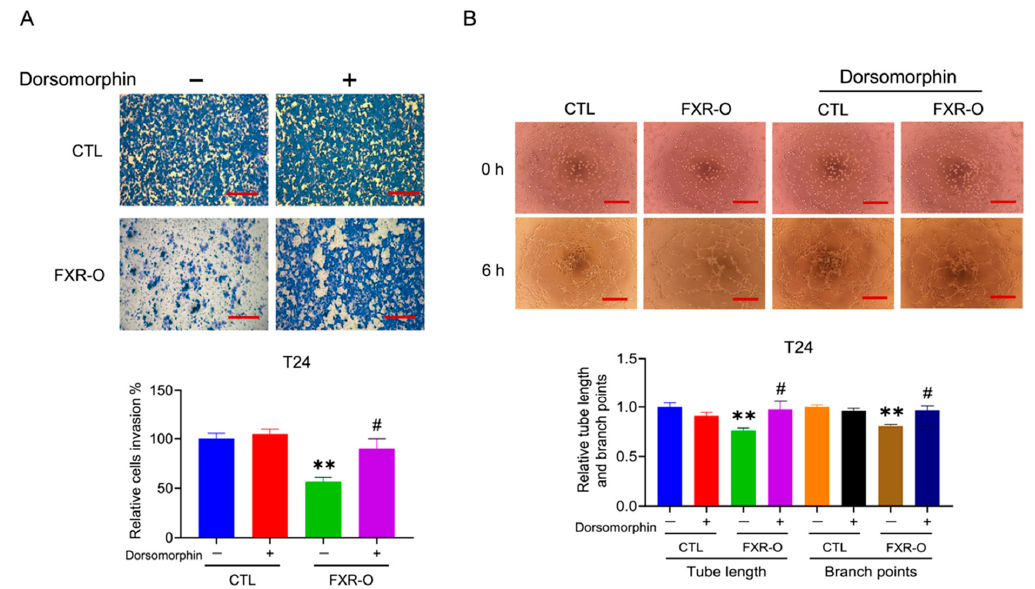
Figure 2. The effect of the AMPK inhibitor dorsomorphin on migration and adhesion in human bladder cancer cells after FXR overexpression. ( A ) The migratory ability of FXR-overexpressing (FXR-O) TSGH8301 and T24 cells treated with or without dorsomorphin (5 µM) was analyzed by wound healing assay after scratching for 6 h. The right panel shows the relative migration rate. ( B ) The adhesive ability in FXR-O TSGH8301 and T24 cells treated with or without dorsomorphin was analyzed after 50 min of incubation. Then, the adherent cells were stained and photographed. The right panel shows the relative numbers of adherent cells. ** p < 0.01 compared to the control group. # p < 0.05; ## p < 0.01 compared to the FXR-O group. Scale bar = 200 µm.